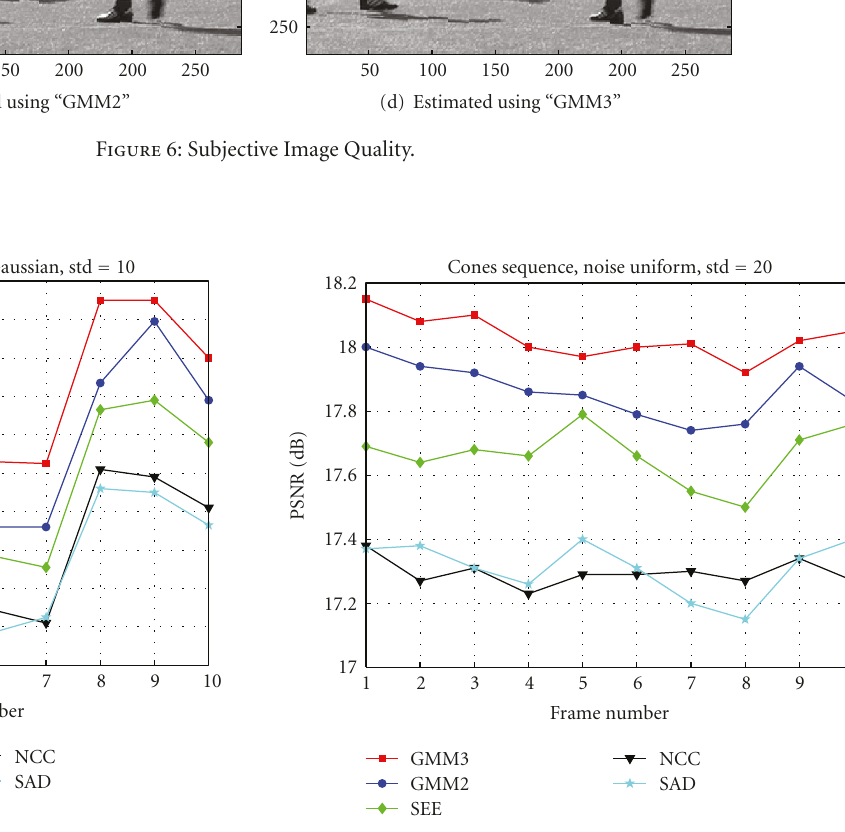
Figure 7: PSNR comparisons of SAD, SSE, NCC, GMM2, and GMM3 methods for the “Soccer” sequence with influence of Gaus- sian noise for standard deviation equal to 10.